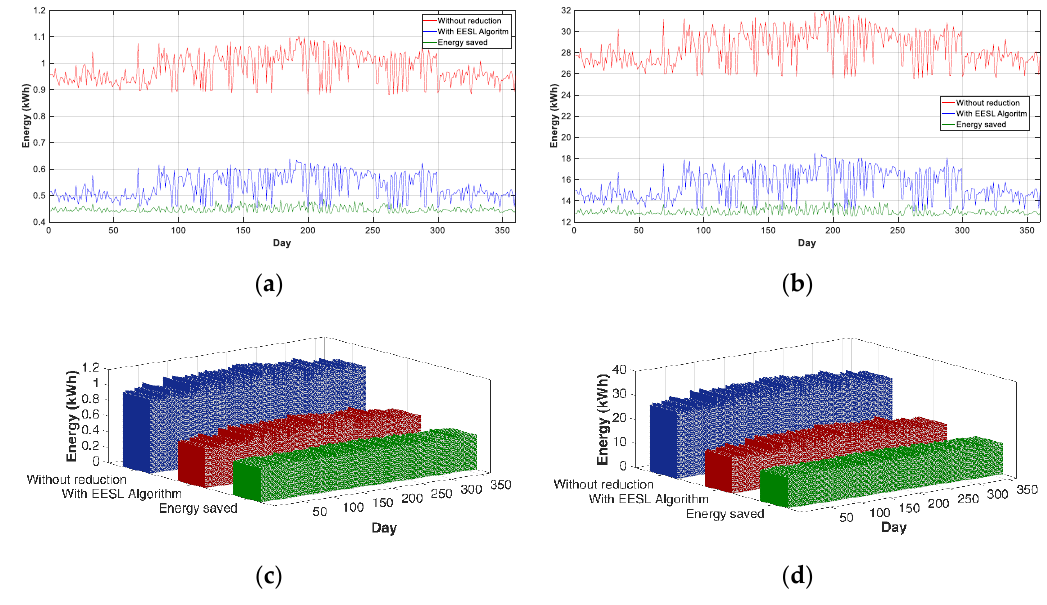
Figure 21. Annual energy saved: ( a ) Active energy per lamp (kWh) 2D; ( b ) Total active energy (kWh) 2D; ( c ) Active energy per lamp (kWh) 3D; ( d ) Total active energy (kWh) 3D.